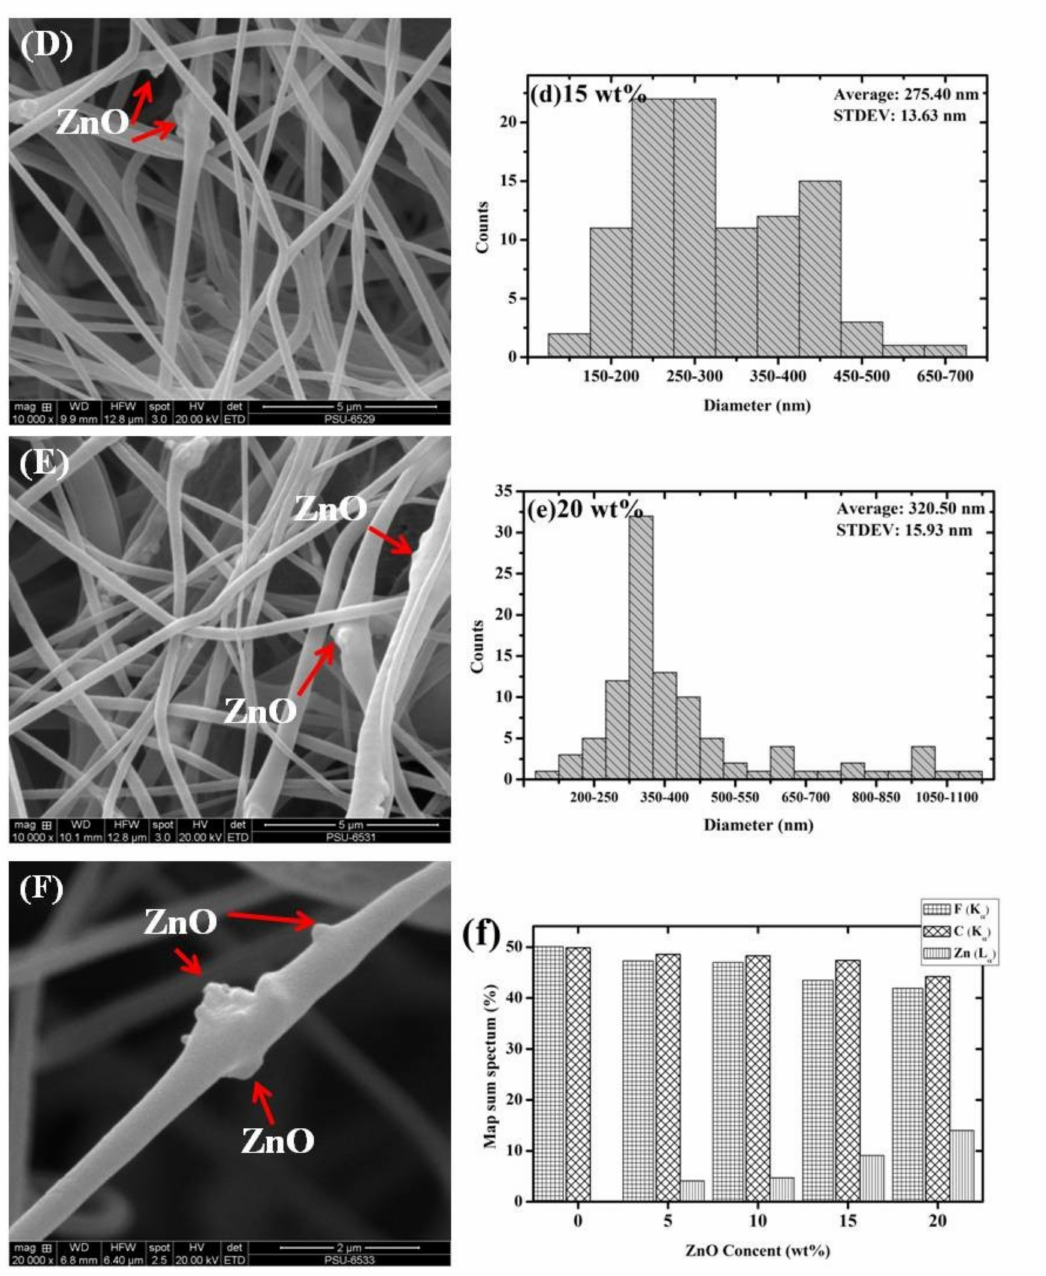
Figure 5. The morphology and diameter distribution statistics of nanofiber: ( A and a ) P(VDF-HFP) nanofiber; ( B and b ) P(VDF-HFP)/ZnO 5 wt%; ( C and c ) P(VDF-HFP)/ZnO 10 wt%; ( D and d ) P(VDF-HFP)/ZnO 15 wt%; ( E and e ) P(VDF- HFP)/ZnO 20 wt%; ( F ) zoom in ZnO on the surface of a P(VDF-HFP)/ZnO 20 wt% nanofiber; and ( f ) elemental mass composition of ZnO in the composite P(VDF-HFP)/ZnO